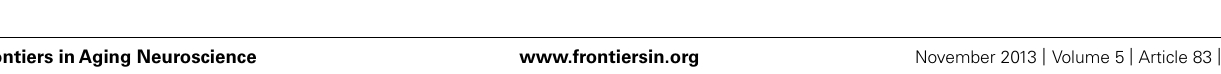
Frontiers inAging